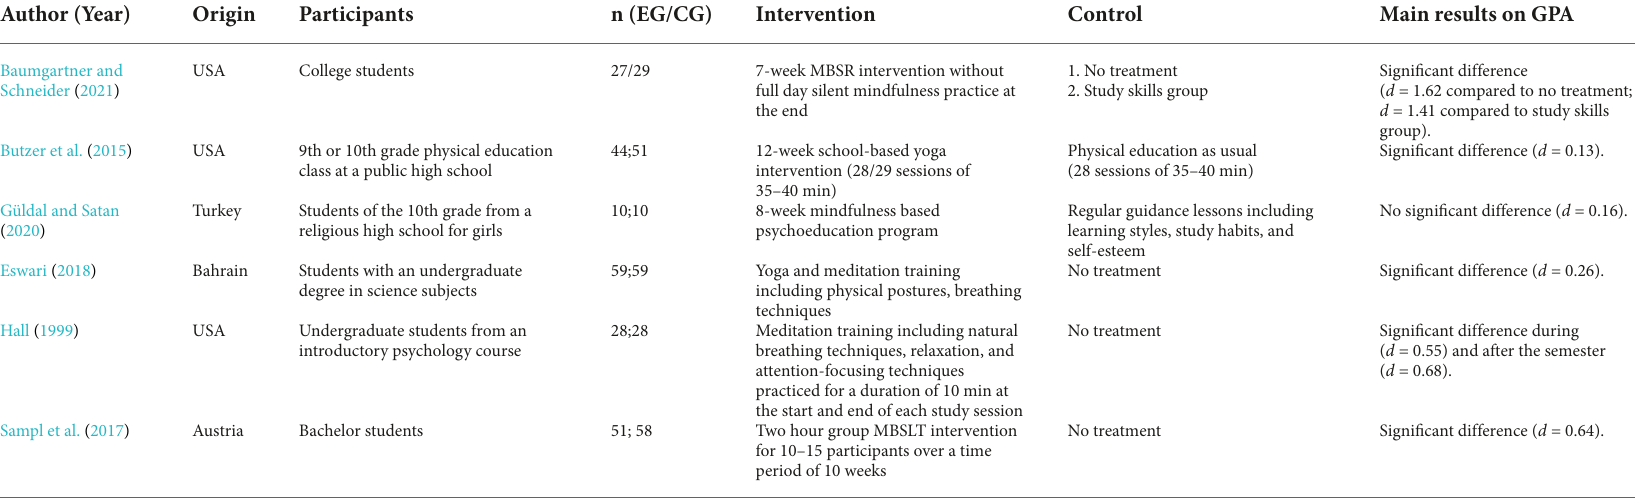
TABLE 1 Tabular overview of the characteristics of the included RCTs (EG: experimental group; CG: control